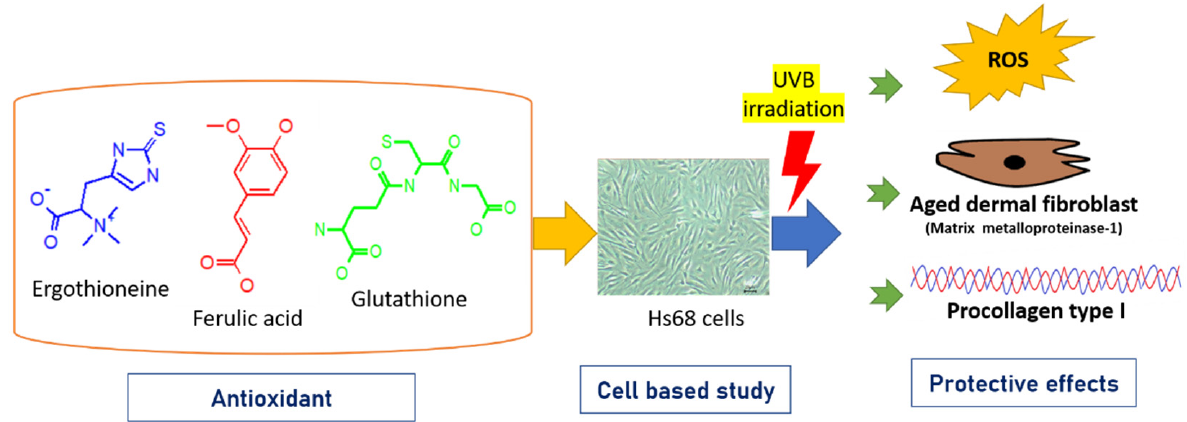
Figure 1. Schematic illustration of three types of antioxidants in the prevention of UVB radiation-induced photoaging in human skin fibroblasts.